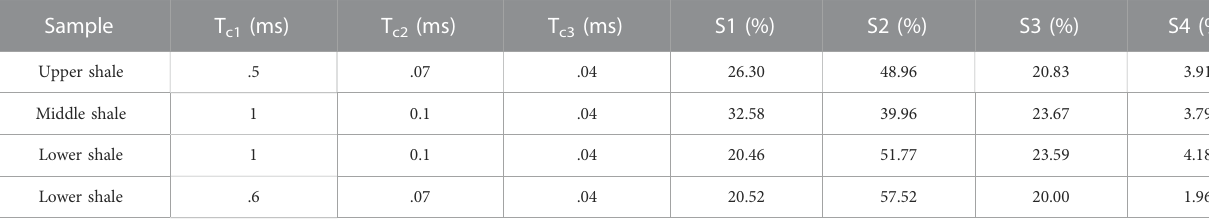
TABLE 2 Statistics of different fl uid types contents and T 2cutoff .